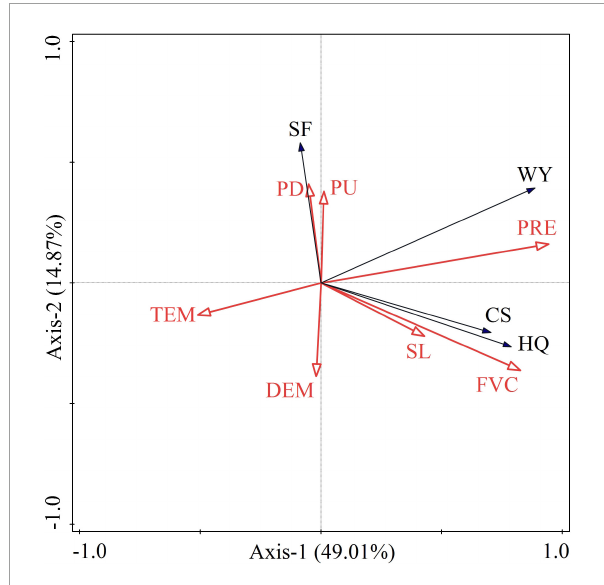
FIGURE5 RDA showing the relationship between four ecosystem services and seven ecological, social drivers. The black arrow represents ecosystem services, and the red arrow represents ecological, and social driving factors. CS, carbon storage; HQ, habitat quality; SF, sand fixation; WY, water yield; DEM, digital elevation model; SL, slope; FVC, fractional vegetation cover; PRE, precipitation; TEM, temperature; PU, percentage of urban area; PD, population density.